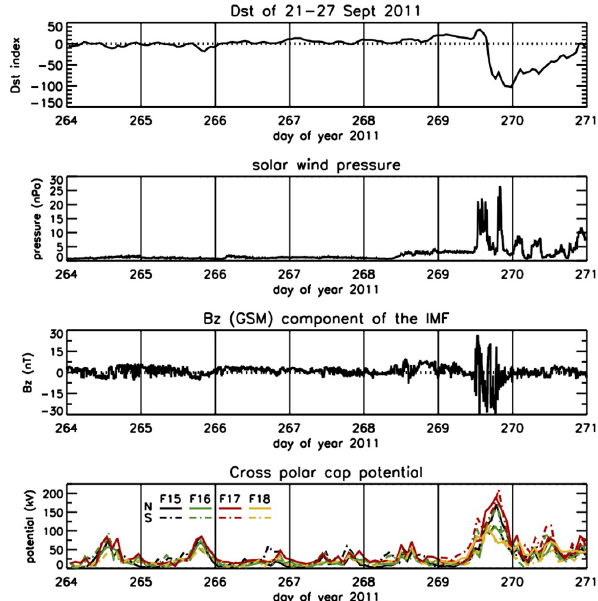
Figure 3. This figure shows (in order) the Dst index, the solar-wind pressure, the B z component of the IMF (in GSM coordinates), and the cross-polar cap potentials in both the Northern and Southern Hemispheres as measured by four DMSP spacecraft for the full seven days of this study. This figure emphasizes how quiet the con- ditions in the IMF, the magnetosphere, and the polar ionosphere were prior to the storm on 26 September (DOY